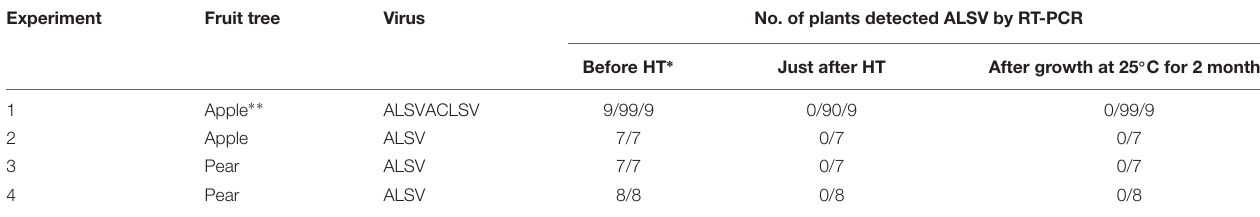
TABLE 3 | Detection of viruses from infected apple and pear shoots before and after incubation at high temperature (HT). Experiment Fruit tree Virus